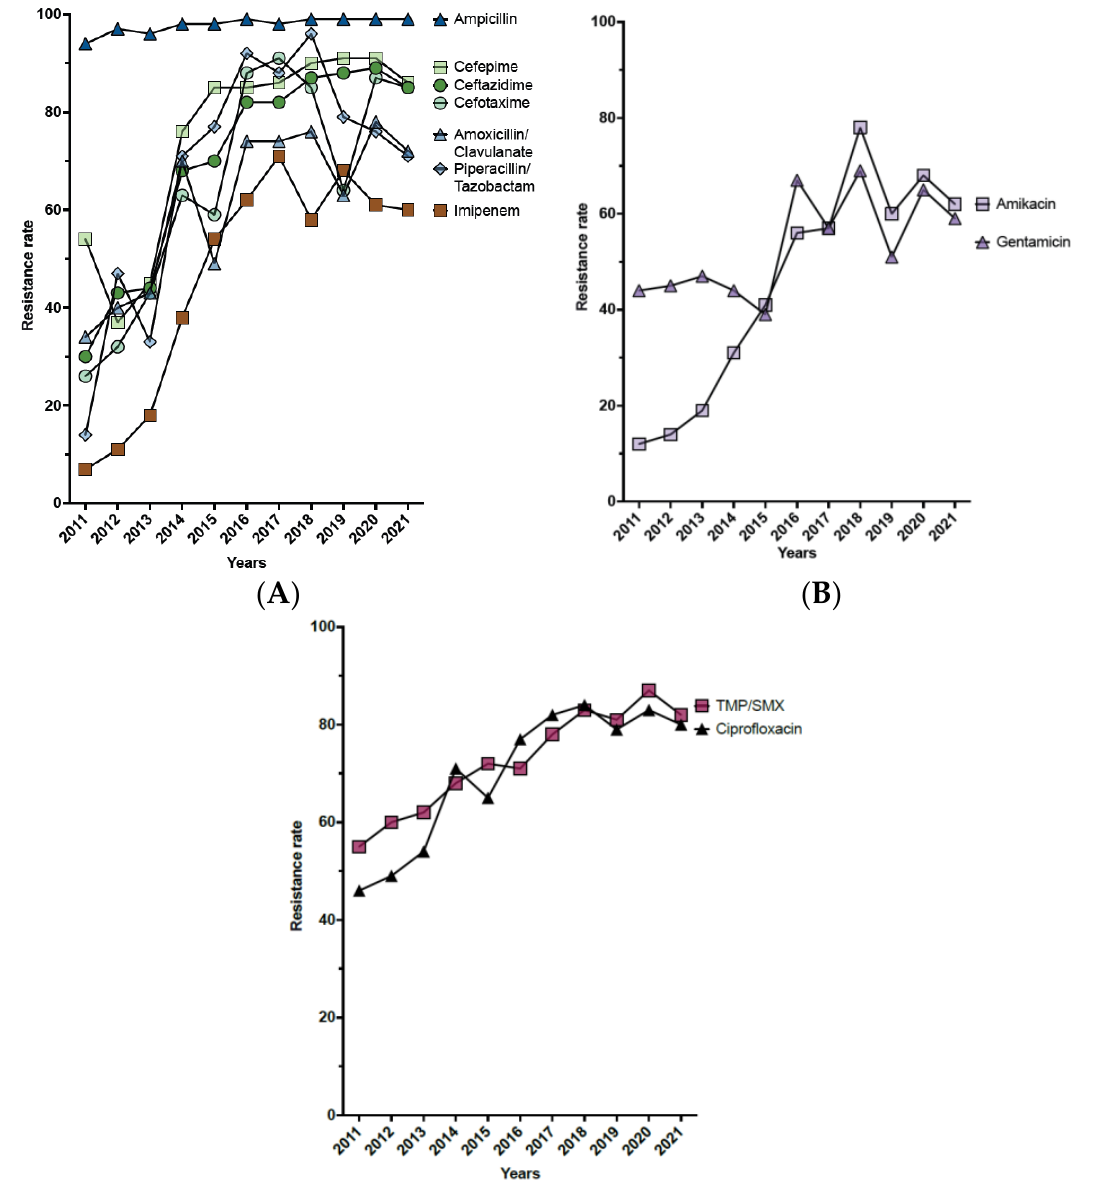
Figure 4. Schematic demonstration of the antimicrobial resistance trends of K. pneumoniae . ( A ). Evolution of resistance to β -lactam antibiotics. ( B ). Evolution of resistance to aminoglycoside. ( C ). Evolution of resistance to ciprofloxacin and cotrimoxazole (trimethoprim-sulfamethoxazole). Next, we examined the prevalence and antimicrobial susceptibility pattern of the extended-spectrum β -lactamase (ESBL) K. pneumoniae (Figure 5). The results showed that the average prevalence of ESBL throughout the study period was 21.3%. In addition, our result showed that ampicillin and cephalosporin exhibited low activity against ESBL K. pneumoniae , with an average resistance rate of more than 90%. In contrast, the most effective antibiotics against ESBL K. pneumoniae were imipenem, with an average resistance rate of 14.63 ± 18.20, followed by tigecycline (19.67 ± 22.97), amikacin (21.31 ± 17.44), and colistin (21.52 ± 35.01) (Figure